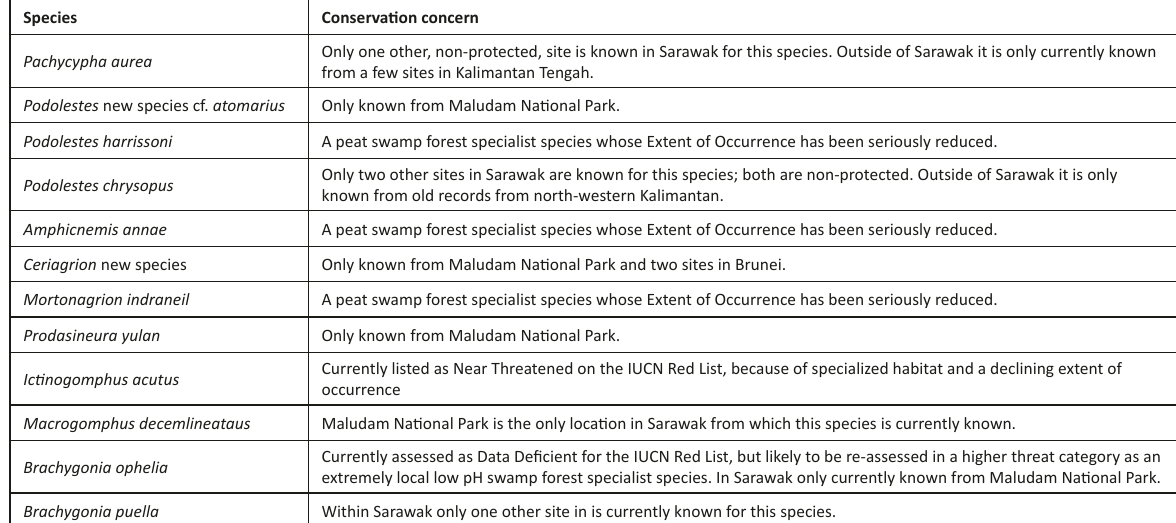
Table 1. Species collected in Maludam National Park in 2012 and potentially of conservation concern either within Sarawak, or globally.